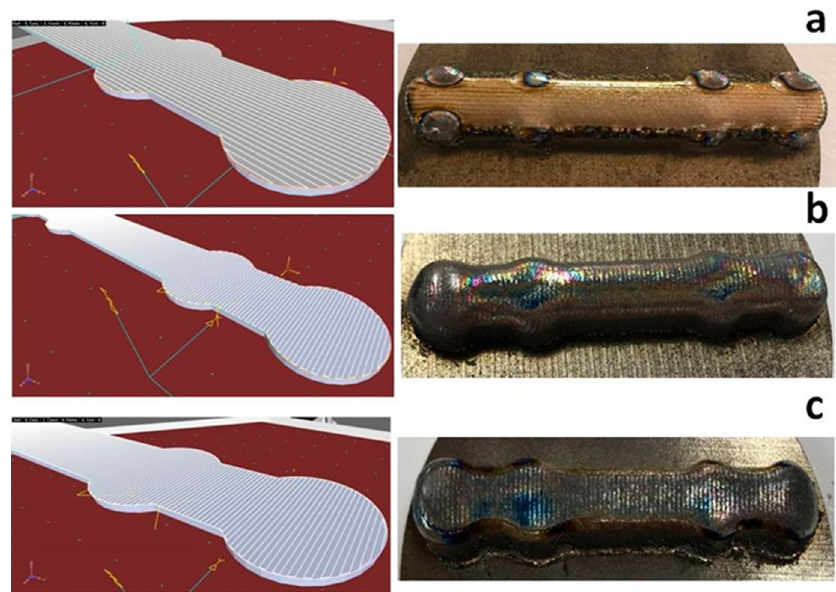
Figure 12. Scanning mode during printing and the resulting incipient form: ( a ) transversal scanning, ( b ) longitudinal scanning, and ( c ) longitudinal scanning with the supplemental contour.